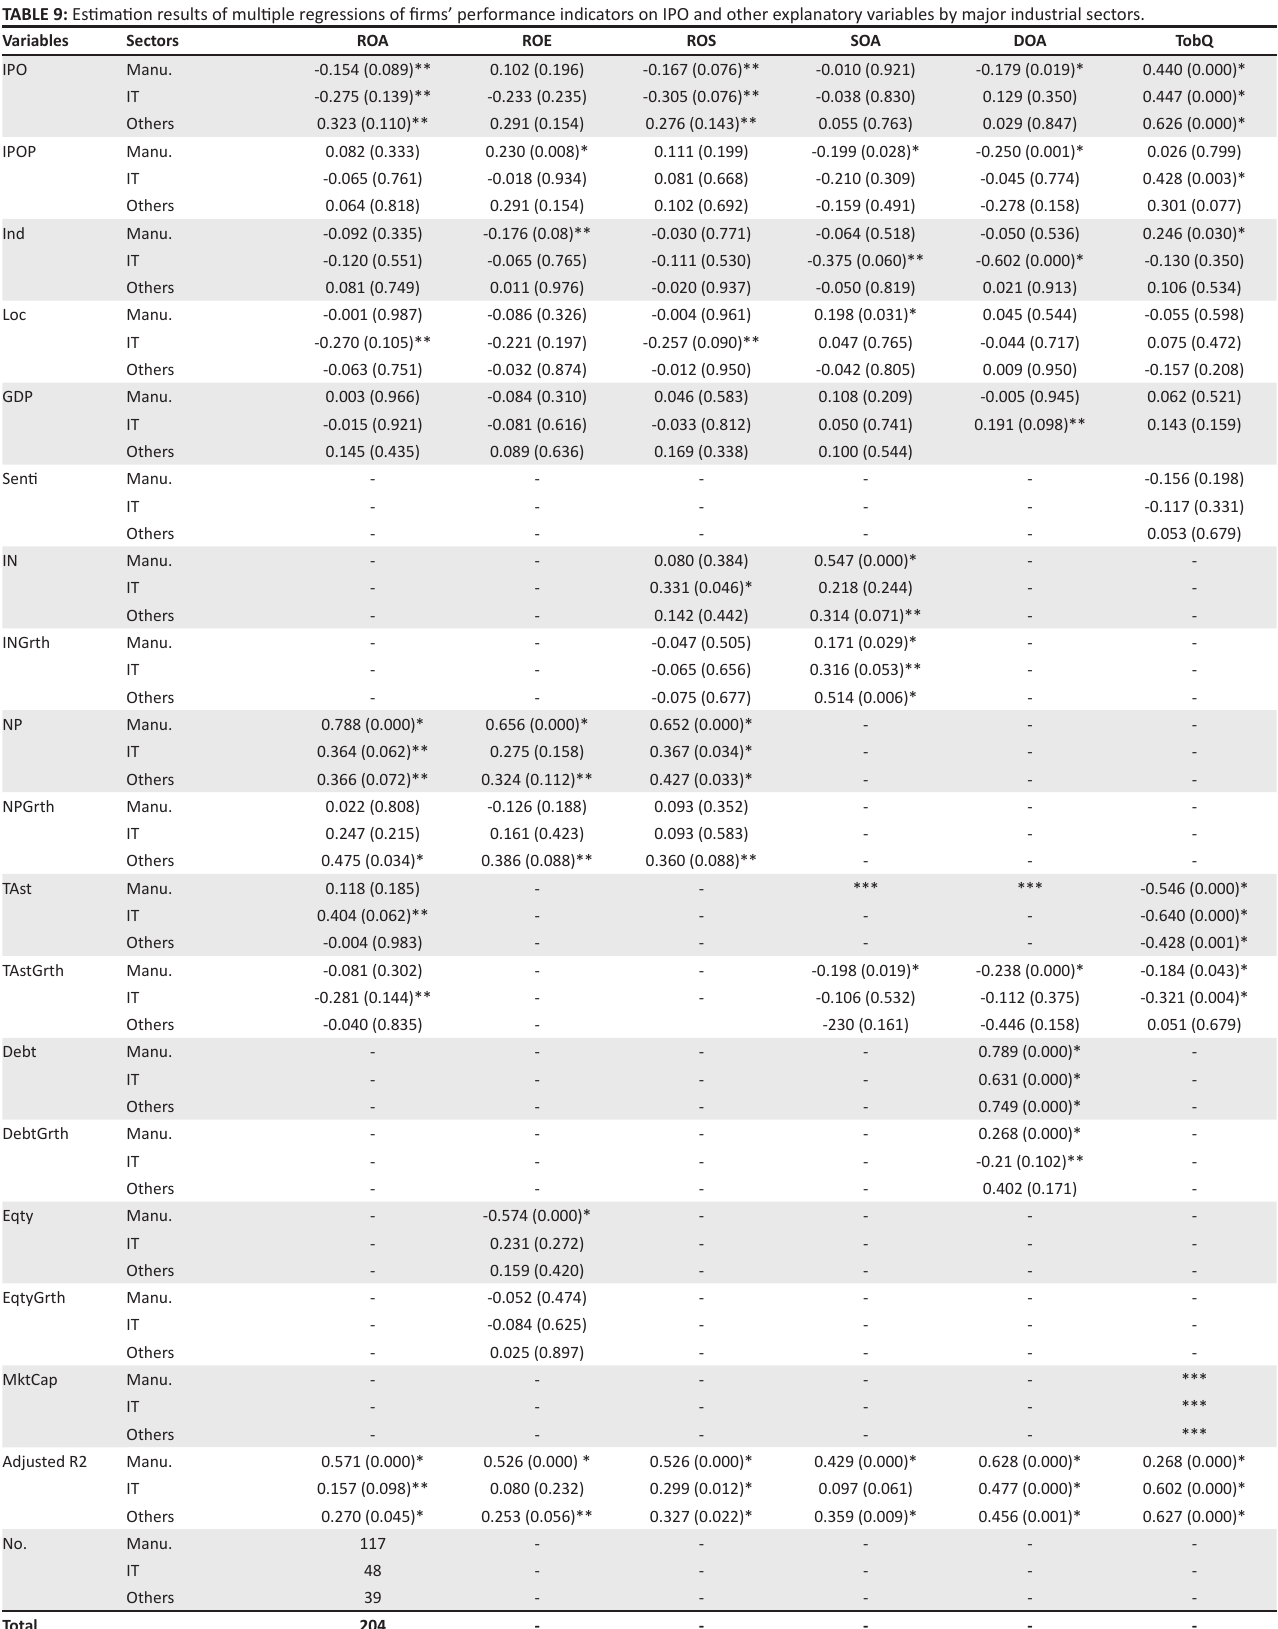
TABLE 9: Estimation results of multiple regressions of firms’ performance indicators on IPO and other explanatory variables by major industrial sectors. Variables